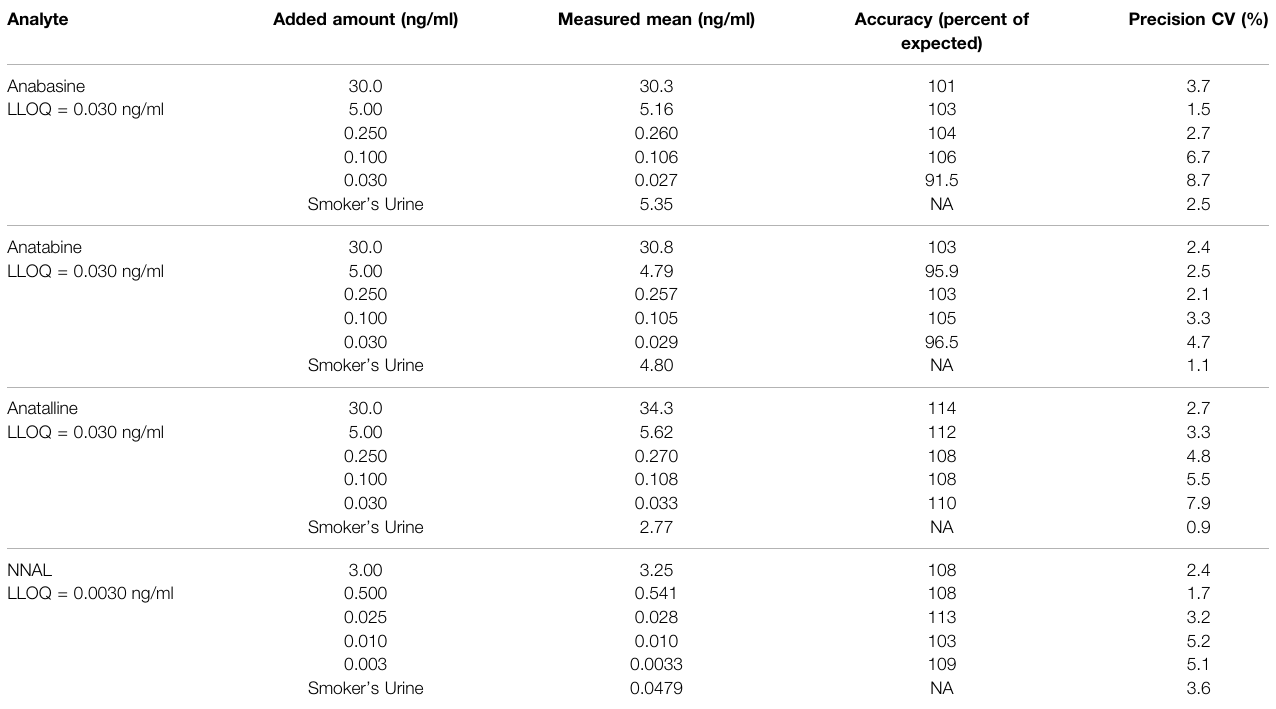
TABLE 3 | Method 2 precision and accuracy for determination of anabasine, anatabine, anatalline, and NNAL in Urine. 6 replicate analyses. 1